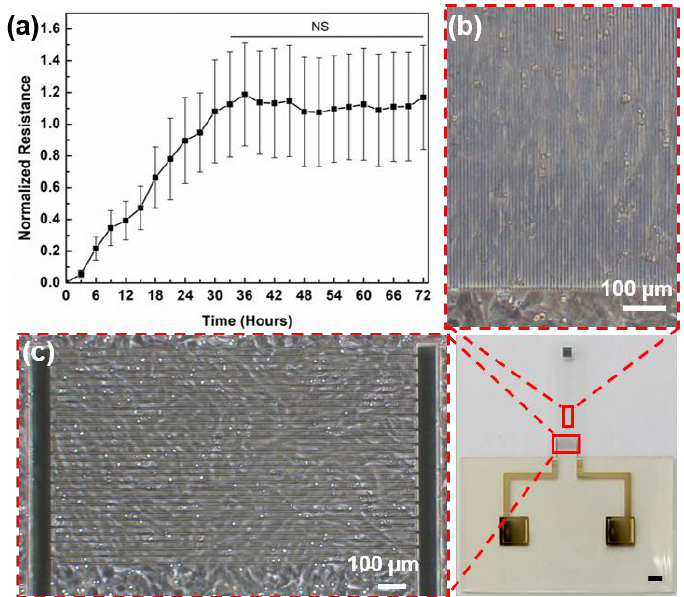
Figure 4. ( a ) Normalized resistance measured for up to 72 h, ( b ) Optical image of distribution of cardiomyocytes on microgroove-patterned cantilever and ( c ) on the IDEs. Scale bar on the device image is 1 mm.